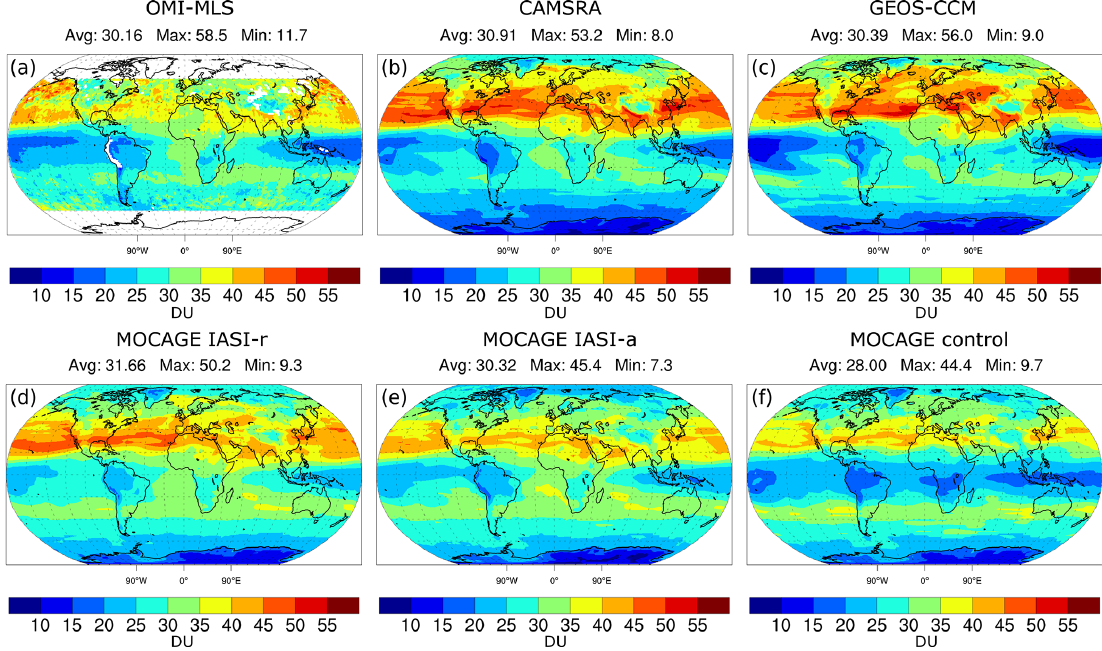
Figure 5. Tropospheric ozone column averaged over March–April–May 2010 from OMI-MLS retrievals (a) , CAMSRA reanalysis (b) , GEOS-CCM simulation (c) , IASI-r reanalysis (d) , IASI-a reanalysis (e) , and the MOCAGE control simulation (f) . Mean, minimum, and maximum values of ozone (in DU) are depicted over each